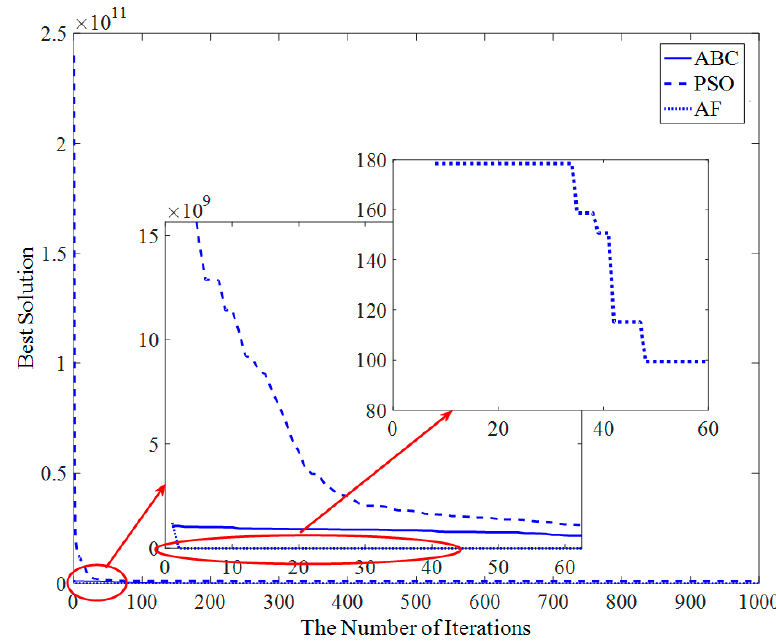
Figure 16. The convergence curve of the three algorithms for Rosenbrock function in 100-dimensional space.